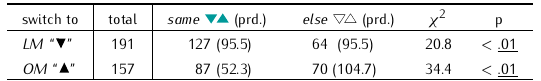
Table 4. Summaries of Gaze-switching and χ 2 Test